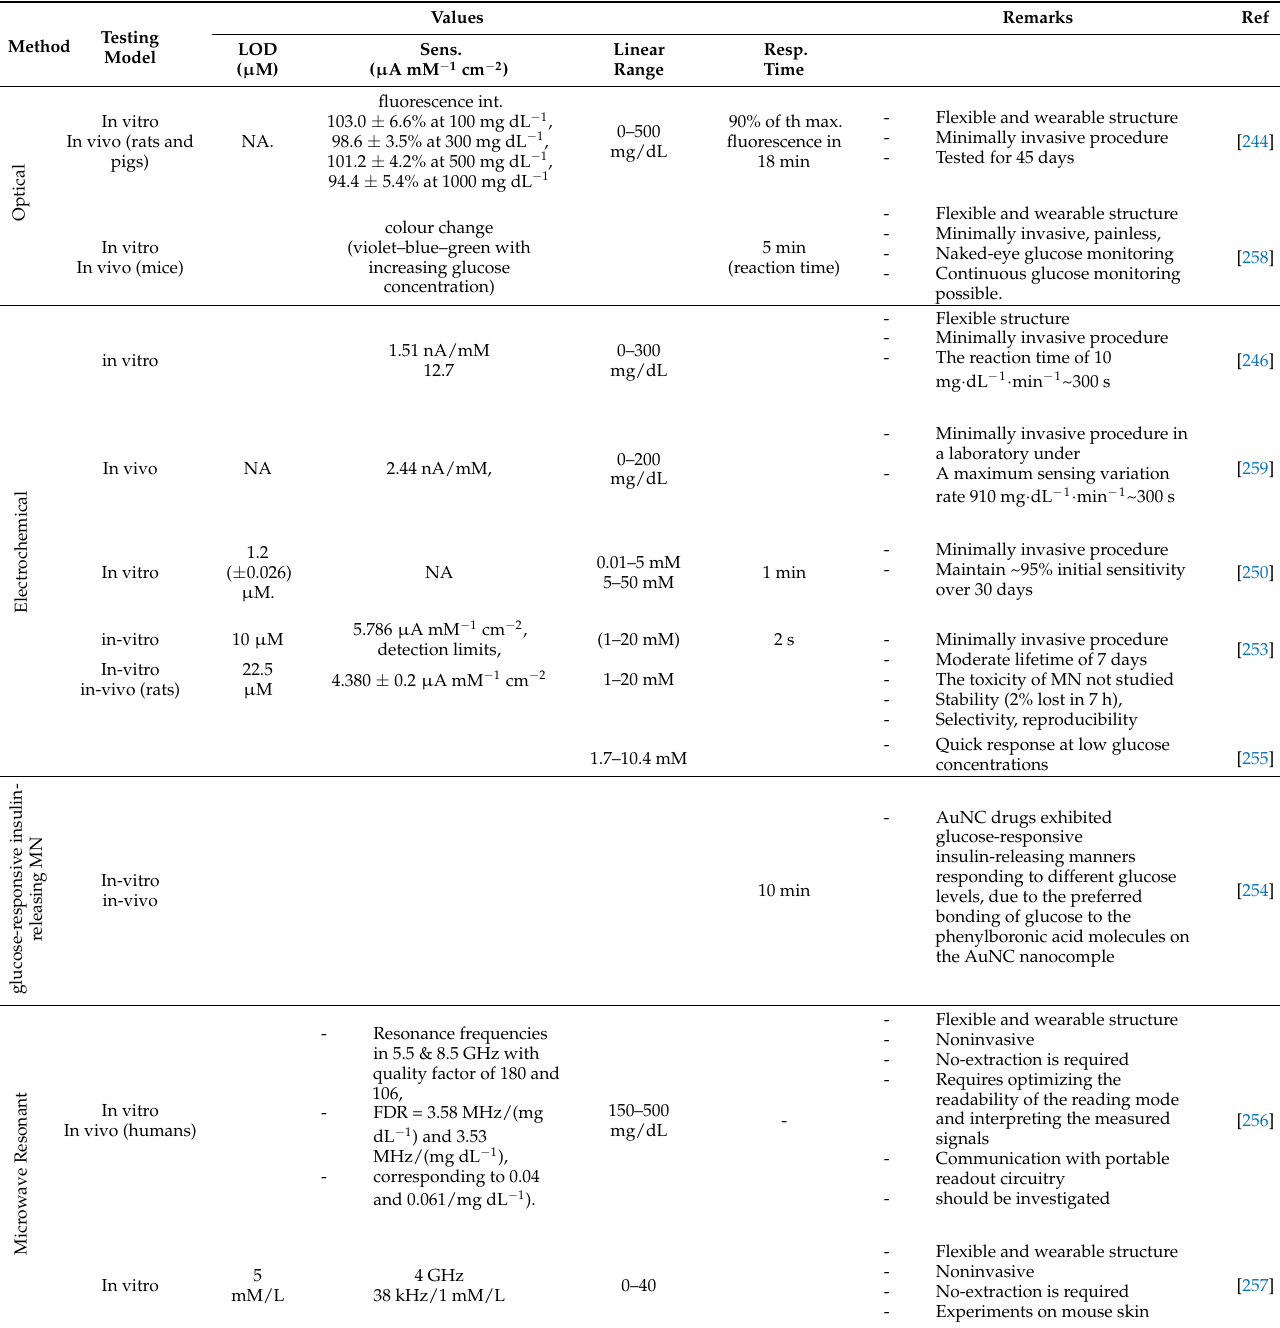
Table 4. Summary of the main e-skin glucose